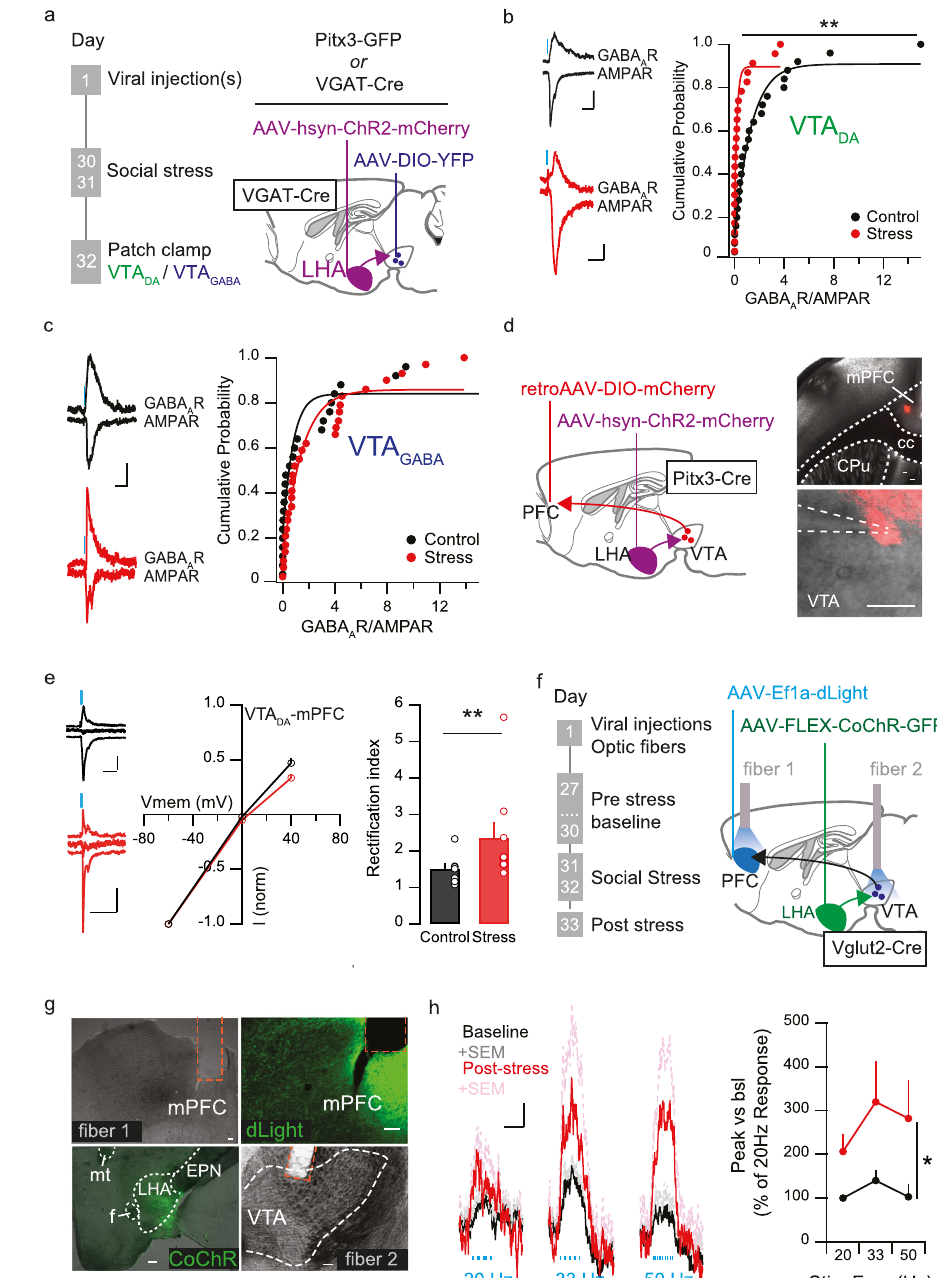
Fig. 4 | Social stress shifts the balance of excitation and inhibition more Left: example traces, scale bars: 50ms, 25pA. Middle: AMPAR current at − 60mV, towards excitation at LHA control over the VTA dopamine system. a Timeline 0mV and +40mV normalized to AMPAR current at − 60mV ( n cells control=7, n cells stress=9). Right: Averages + SEMs ( n cells control=7, n cells stress=9, KS- and schematic for stress protocol for electrophysiological patch clamp experi- test,D (1,15) =1.70, p =0.006). f Timeline and schematic forinvivo fi ber photometry ments of VTA DA and VTA GABA neurons. b GABA A R-AMPAR ratios at LHA-VTA DA synapses decreased post stress. Left: representative AMPAR and GABA A R traces. experiment to assess mPFC dopamine release as a function of LHA glu -VTA stimu- Blue rectangle: start of LED stimulation. Scale bar: 25pA, 20ms. Right: Cumulative lation. g Representative images of CochR-GFP virus expression in LHA glu cells (green),optogeneticstimulation fi berabove theVTA,dLightexpressioninthePFC probability plot quanti fi cation ( n cells control=23, n cells stress=25, KS-test, D =0.499, p =0.003). c GABA (green) witha photometry fi ber.Scale bars: 100 µ m.Anatomicalreferencepoints:f A R-AMPAR ratio at LHA-VTA GABA synapses. Left: representative AMPAR and GABA A R traces. Scale bar: 40pA, 25ms. Right: Cumu- fornix, EPN entopeduncular nucleus, mt mammillo-thalamic tract. h Left: Average lativeprobabilityplotquanti fi cation( n cellscontrol=25, n cellsstress=29,KS-test, +SEM of emitted fl uorescence in mPFC for LHA glu -VTA stimulation frequencies of D =0.34, p =0.074). d Left: Schematic of patch clamp experiments of VTA 20,33and50Hzforpreandpoststress( n mice=6).Right:Averages+SEMs.Stress DA neu- rons projecting to mPFC. Right: representative image of viral expression of increases dopamine release in mPFC post-stress, peak DA release (RM Two-Way retroAAV-DIO-mCherry (+ diluted red beads for injection site veri fi cation) in hor- ANOVA. Main effect stress F (1,5) =6.92, p =0.047). Scale bars: 10s, 0.05 dF/F. All statistical tests were performed two-sided. * p <0.05, ** p <0.01. Source data are izontal sections. mPFC (top) Scale bar: 100 µ m, VTA (bottom) scale bar: 20 µ m. provided as a Source Data fi le. Anatomical reference points cc corpus callosum, CPu caudate putamen. e AMPAR Recti fi cation index increases at LHA glu -VTA DA -mPFC synapses after stress.